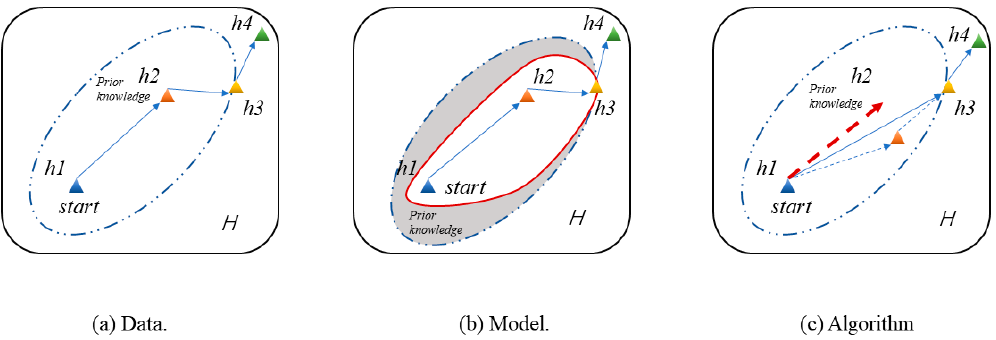
Figure 2. Di ff erent categories of few-shot Figure 2. Different categories of few-shot learning.